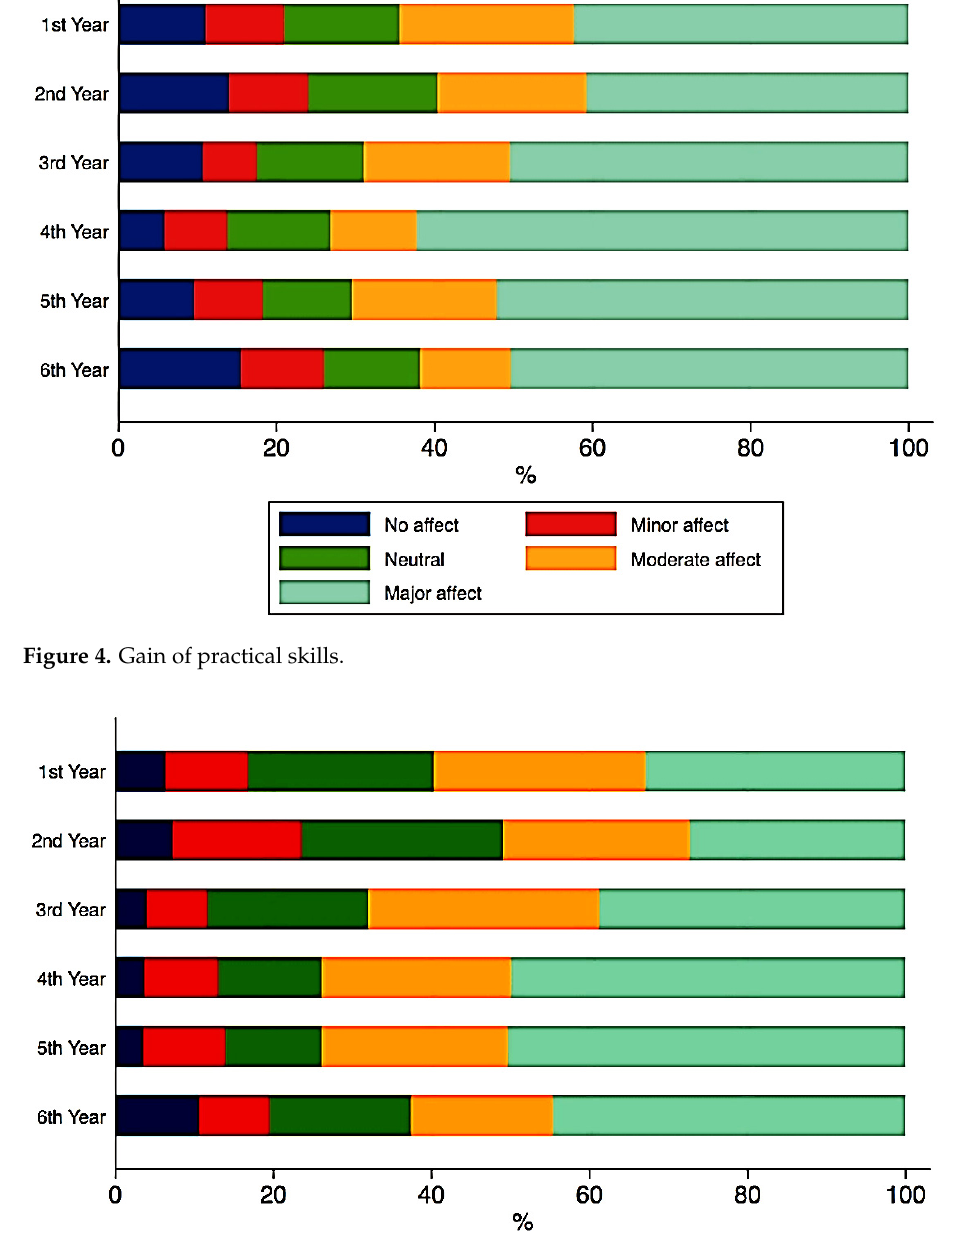
Figure 3. Time for individual study.